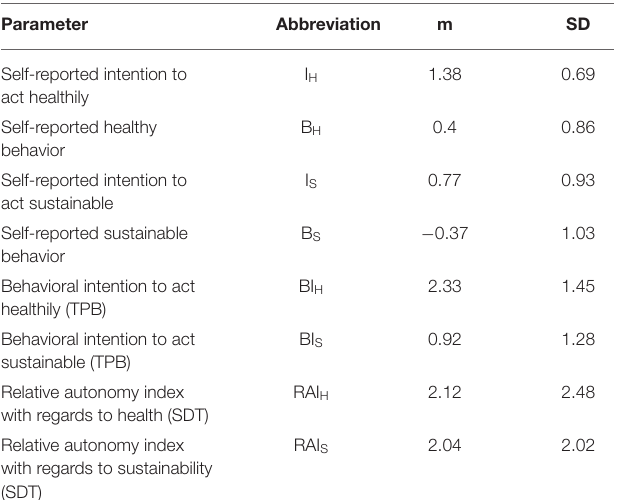
TABLE 2 | Abbreviations for the variables (including means and standard deviations).